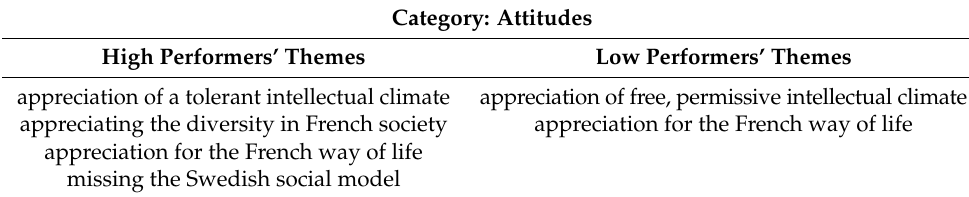
Table 6. Identified themes in the category